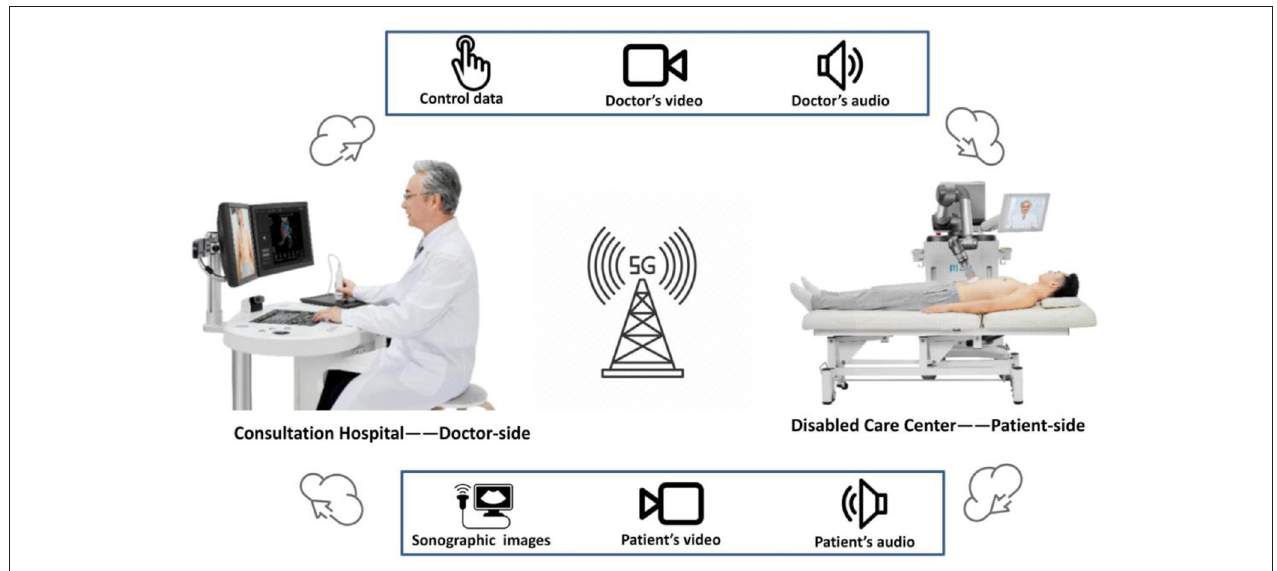
FIGURE 1 | The 5G-based robot-assisted remote ultrasound (MGIUS-R3) comprises two parts: the doctor-side subsystem and the patient-side subsystem. The control data, doctor’s operational video, and voice are sent in real time to the patient side through the 5G network. The sonographic images, video of robotic arm manipulation, and patient’s audiovisual signal are sent in real time to the doctor